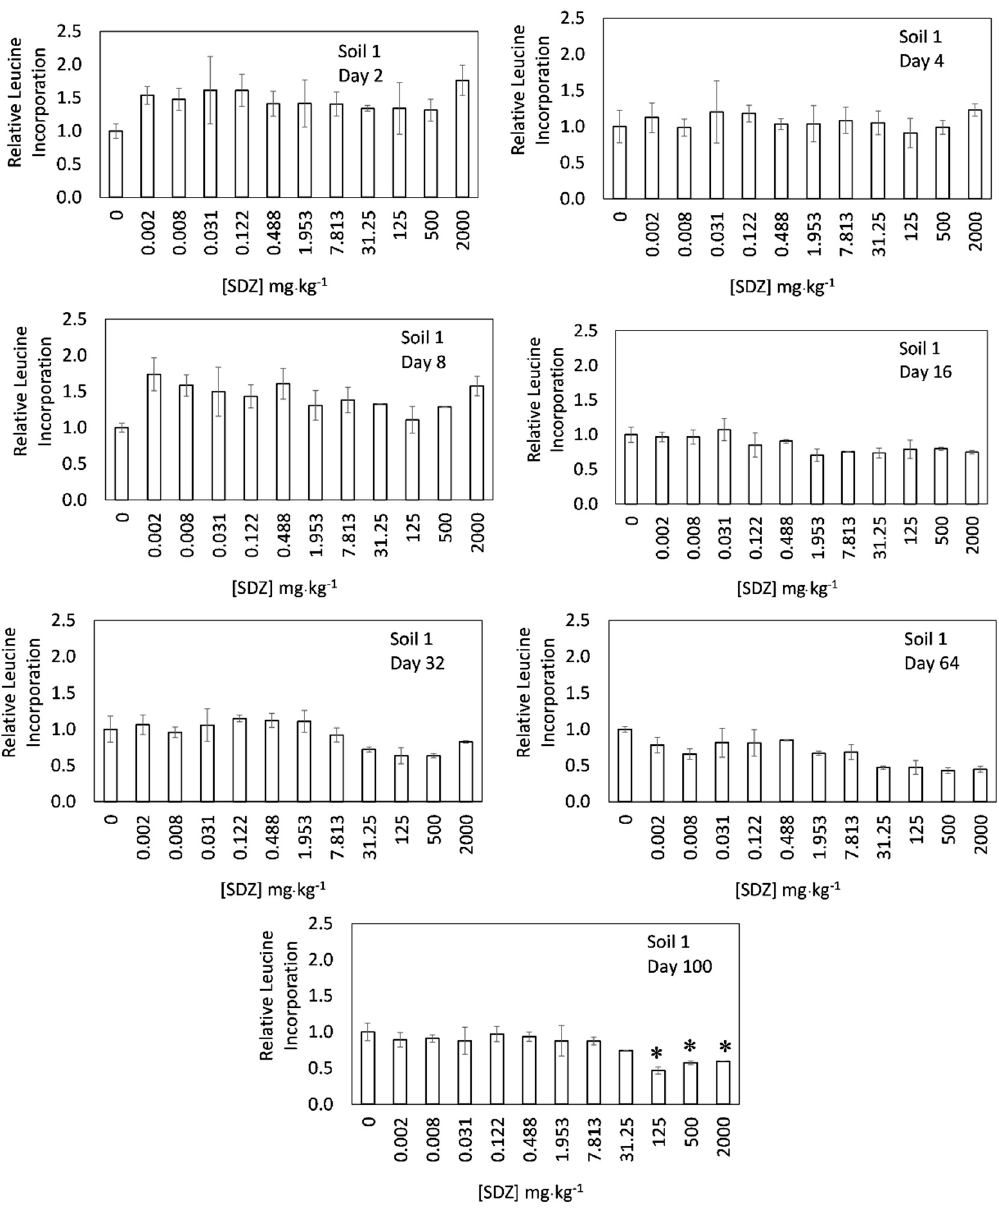
Figure 1. Relative bacterial community growth (estimated as 3 H Leucine incorporation) in soil 1 as a function of sulfadiazine concentration added for different incubation times. Error bars show the standard errors from average values ( n = 3), and * indicates significant differences with respect to the control ( p < 0.05).